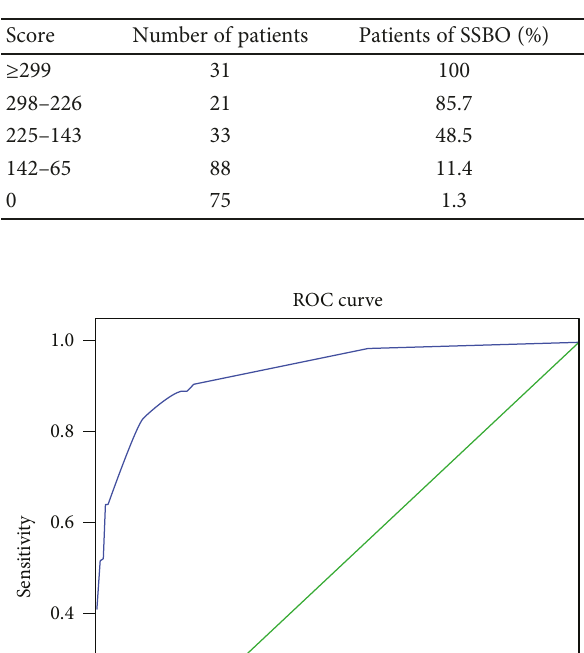
Table 5: Classi fi cation of patients with strangulated small bowel obstruction (SBBO) according to the score.